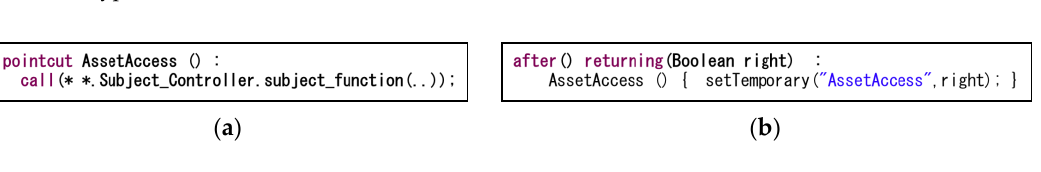
Figure 9. ( a ) Pointcut considering a regular or non-regular user and ( b ) advice to differentiate between the two types of users.